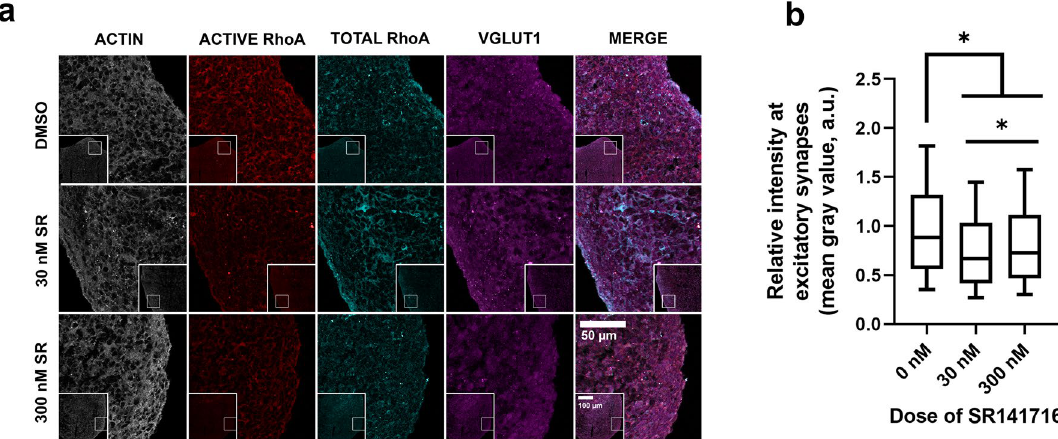
Figure 3. CB 1 selective antagonism by SR141716A in 90-day old cortical spheroids decreases activity of actin regulator GTPase RhoA ( a ) Representative confocal images of cyrosectioned cortical spheroids stained with Active RhoA, Total RhoA, and excitatory presynaptic marker VGLUT1. Activated RhoA was distinguished from total RhoA by an antibody bound to the GTP form of RhoA (activated). An antibody bound to the GDP